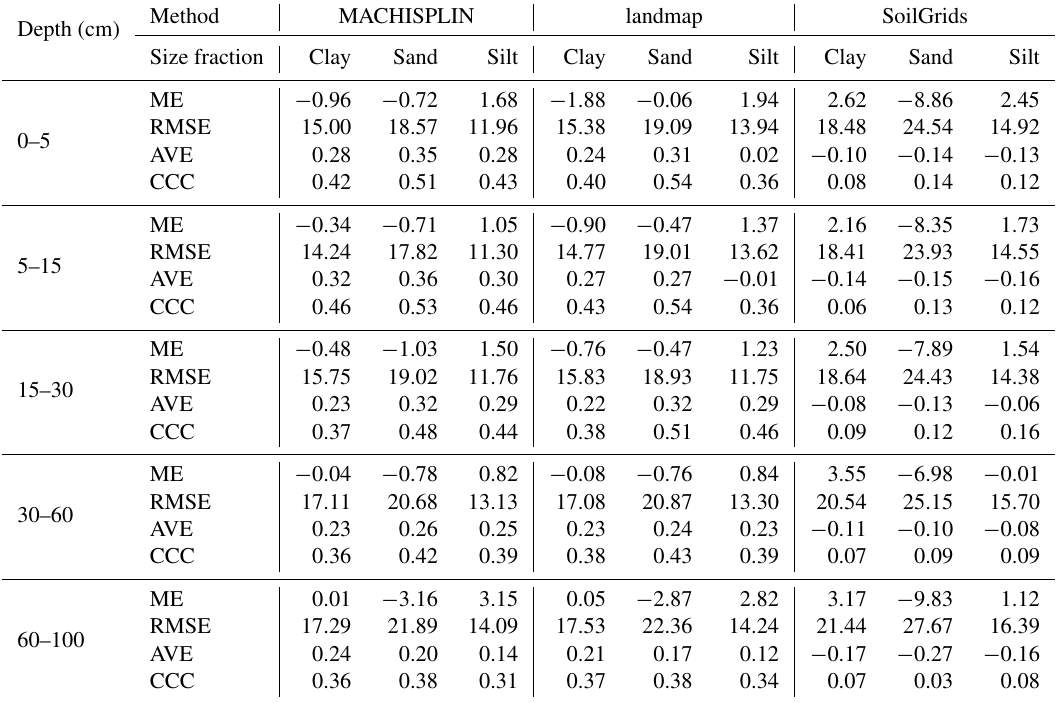
Table 4. Map quality measures of each algorithm for PSF in five standard depths. ME: mean error; RMSE: root square mean error; AVE: amount of variance explained; CCC: concordance correlation coefficient. These map quality measures are based on the validation dataset.